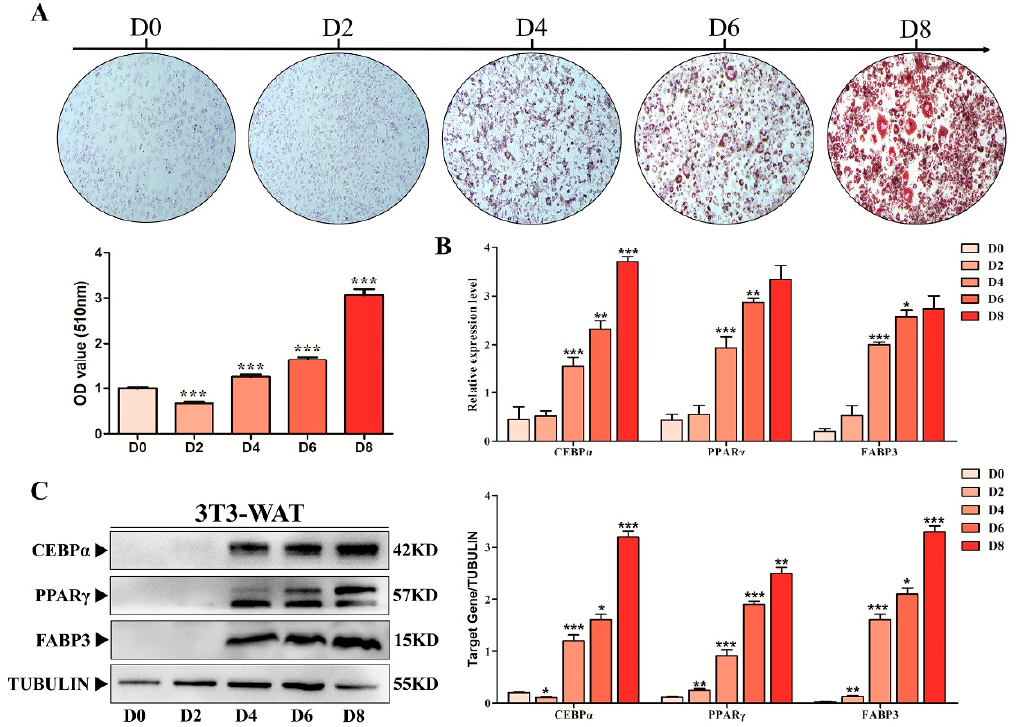
Figure 4. FABP3 positively correlated with the adipogenic differentiation. ( A ) ORO staining and quantification gradually increased from 0 to 8 days (scale bar = 150 mm). ( B ) The mRNA expression levels of PPAR γ , C/EBP α and FABP3 during adipogenic differentiation. ( C ) The protein expression levels of PPAR γ , C/EBP α and FABP3 during adipogenic differentiation; * p < 0.05; ** p < 0.01, *** p < 0.001.